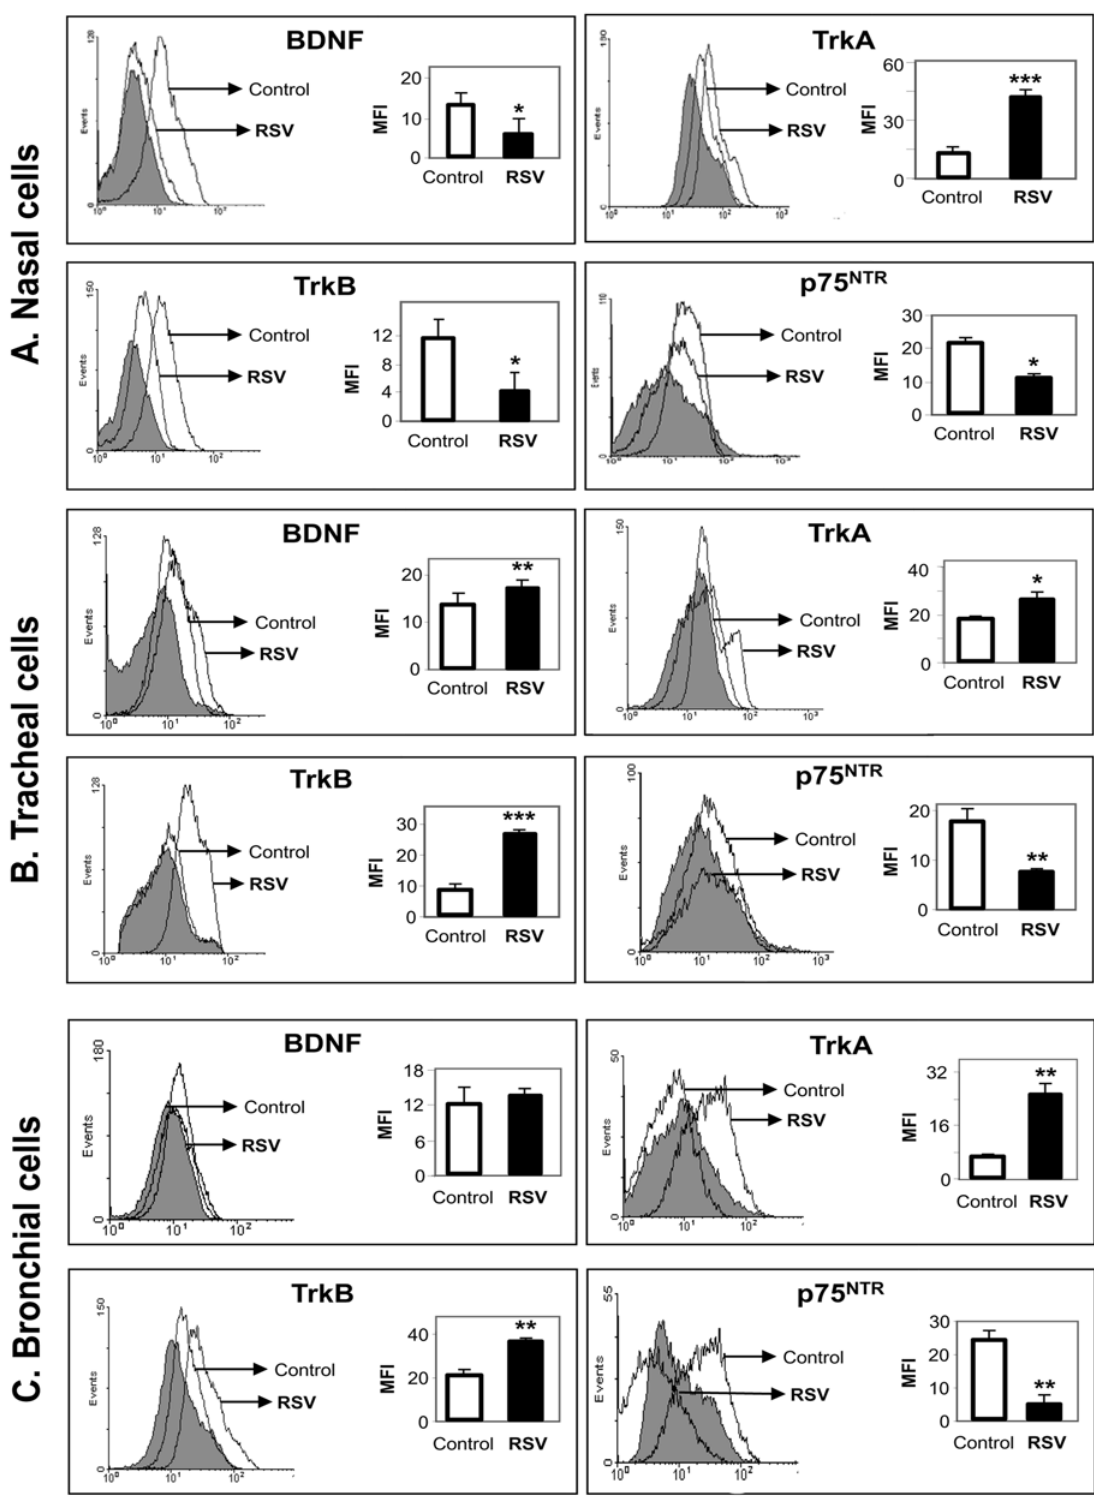
Figure 4. RSV-induced modulation of neurotrophic growth factors and their receptors in (A) nasal epithelial cells; (B) tracheal epithelial cells; (C) bronchial epithelial cells. Confluent plates of epithelial cells were infected with 1 MOI of rgRSV; after 6 h, the excess viral particles were removed and fresh culture medium added. Subsequently, cells were harvested at 48 h and stained with specific antibody or its matched isotype control (shaded histogram). Cells not exposed to rgRSV were used as controls. Changes in protein expression were measured by flow cytometry using suitable secondary antibodies conjugated with phycoerythrin (PE) or allophycocyanin (APC). Geometric mean fluorescent intensity (MFI) is presented in bar graphs. Data are expressed as the mean 6 SEM (n=4 experiments). *= p , 0.05; **= p , 0.01; ***= p , 0.001 compared to non-infected controls.